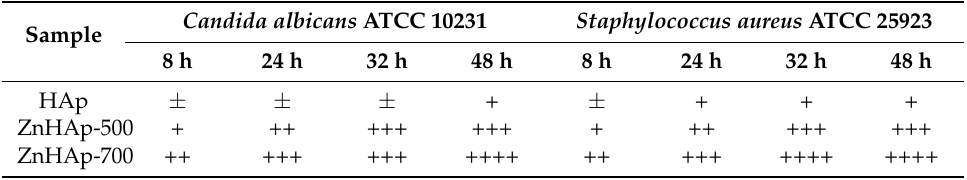
Table 1. Qualitative screening of the antimicrobial activities of the HAp, ZnHAp-500, and ZnHAp-